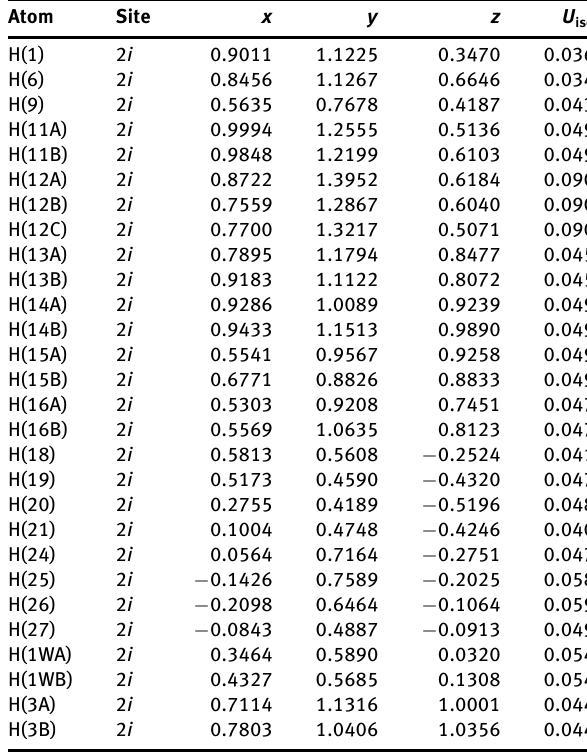
Table 2: Fractional atomic coordinates and isotropic or equivalent isotropic displacement parameters (Å 2